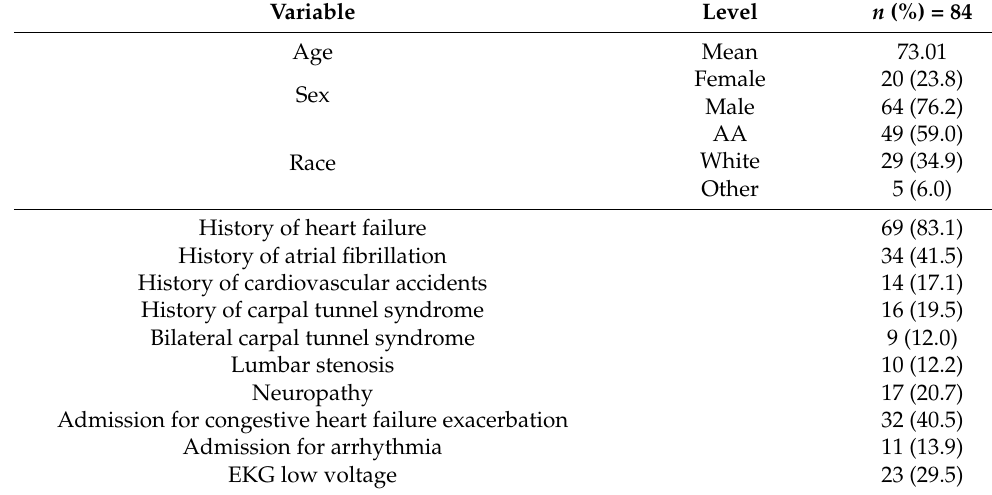
Table 1. Descriptive